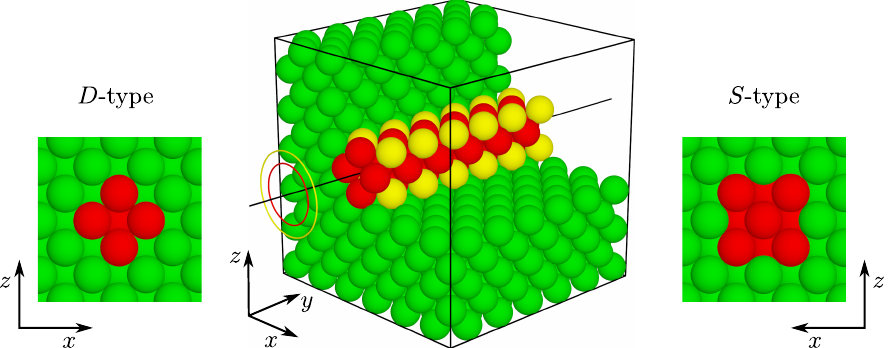
Figure 1. Illustration of two channels sizes studied in this work. Depending on the desired diameters (colored circles), the smaller channel incorporates the on-axis particles and their nearest neighbors ( D -type), marked in red. The larger channel ( S -type) contains all the D -type particles plus the particles from the second coordination zone around the channel axis, colored yellow. The yellow color has been used only to highlight the differences between the two channel sizes. The circles represent the diameters of the corresponding coordination zones. Inserts on the left and right present the D -type and S -type channels, respectively, viewed from the y -direction (along the channels’ axis). For clarity, part of the green (matrix) spheres located outside the channel have been removed from the